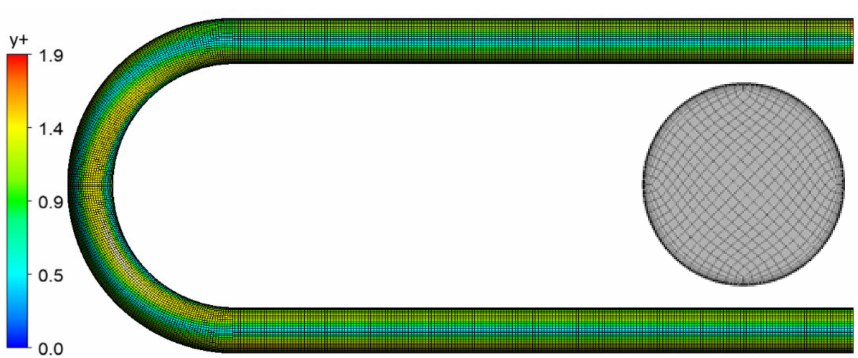
Figure 3. A typical space discretization of the fluid domain and y+ distribution for 8 m/s